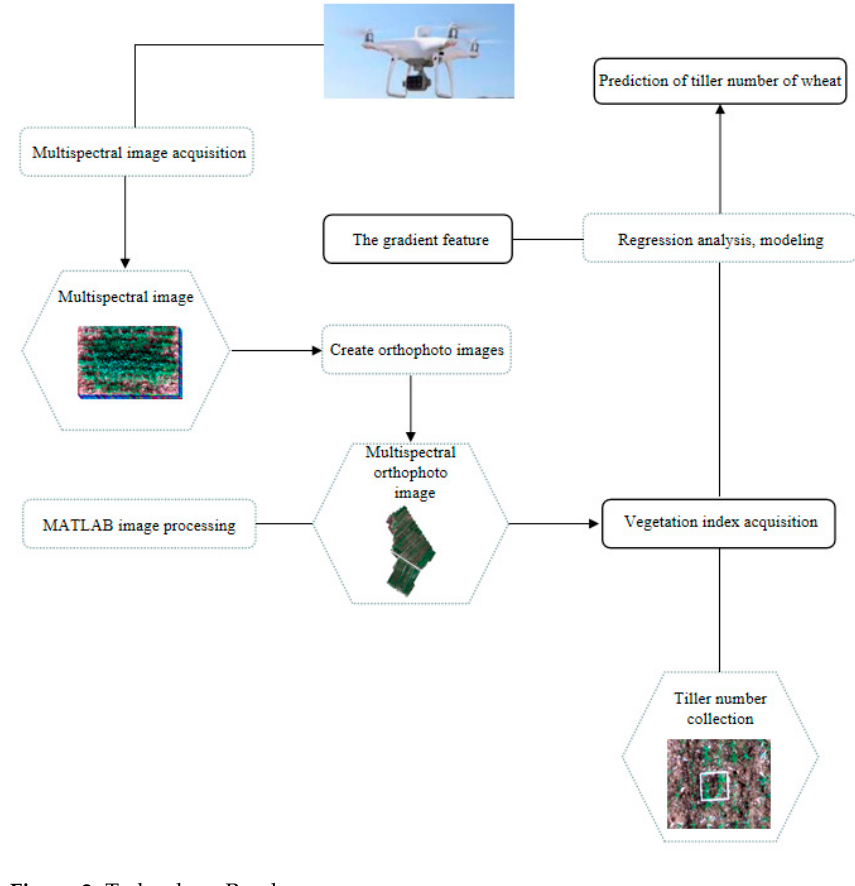
Figure 2. Technology Road map.